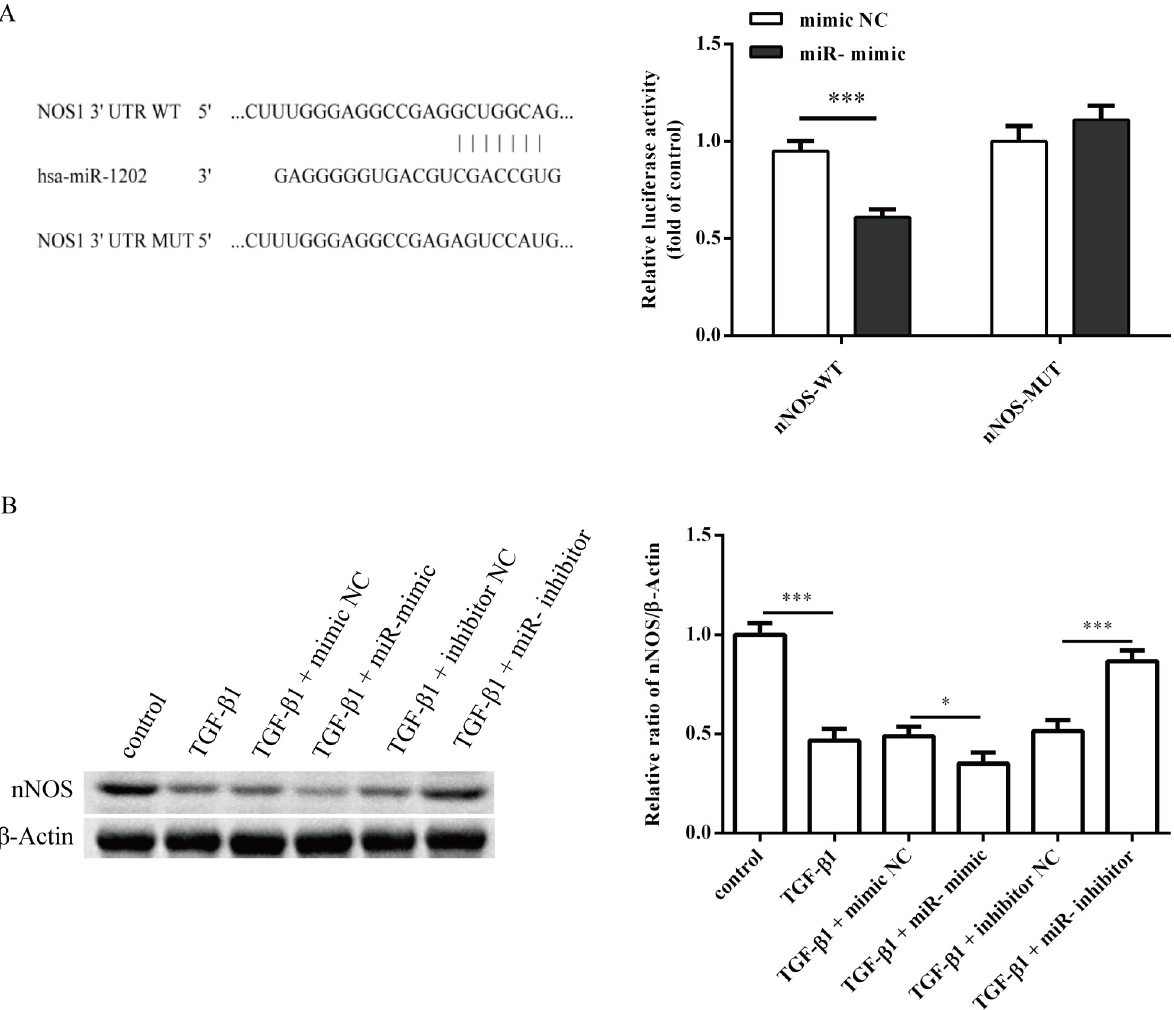
Fig 6. nNOS is a target of miR-1202. (A) Left: Binding sites for miR-1202 in the 3’-UTR of nNOS mRNA; Right: Luciferase reporter assay showing reduced luciferase reporter activity in HCFs containing the nNOS-WT 3’-UTR fragment. (B) nNOS protein expression in HCFs infected with miR- 1202 mimic or miR-1202 inhibitor was measured after 48 h. All of the data are expressed as the mean ± SD. Compared with the control group. n = 3, � P < 0.05; �� P < 0.01; ��� P < 0.001. The analysis is not able to detect small significant differences due to small sample size.